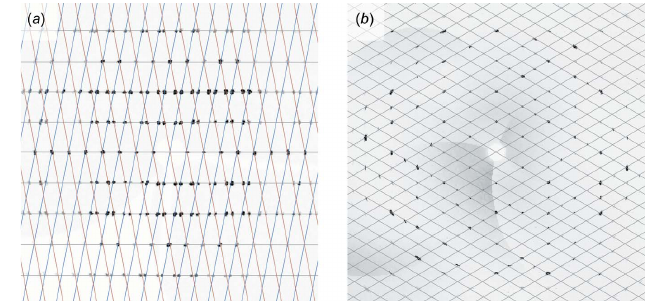
Figure 2 Reciprocal-lattice-slice reconstructions ( h 0 l ) for ( a ) a crystal twofold twinned by non-merohedry, requiring two orientation matrices to account for all diffraction maxima, and ( b ) a crystal twinned by pseudo- merohedry (see structure WUGLES, Section 4), for which a single orientation matrix accounts for all observed diffraction. The latter gives little outward indication of it being a twin, other than slight elongation of diffraction spots at higher 2 (cid:3) angles.